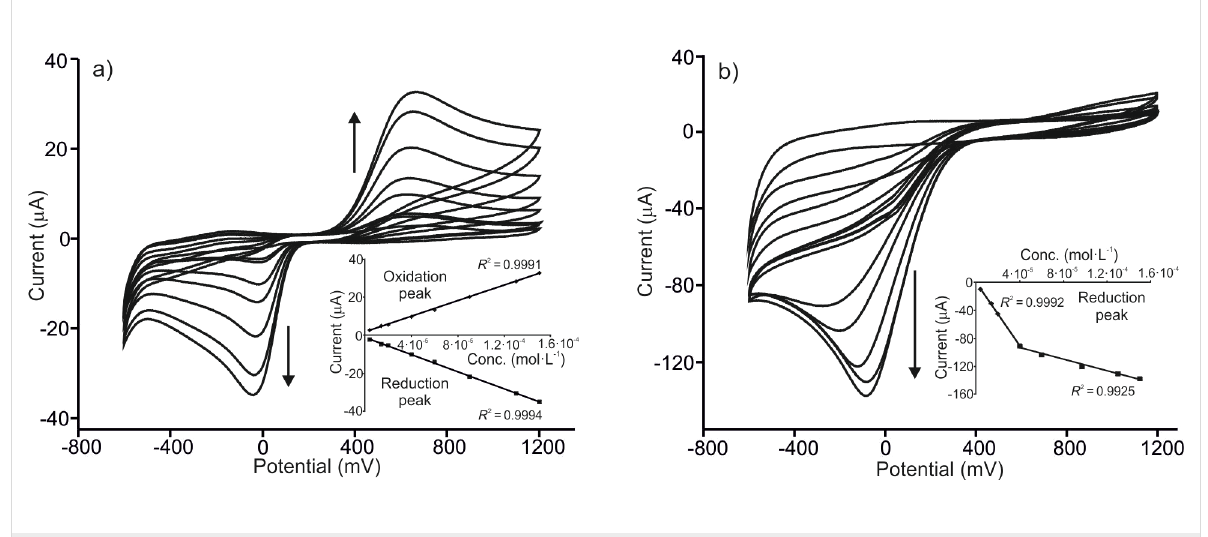
Figure 6: CVs of (a) PEDOT/PSS/LuPc 2 and (b) PEDOT/PSS/LuPc 2 -Tyr immersed in increasing concentrations of catechol (from 4.0 × 10 − 6 mol·L − 1 to 1.5 × 10 − 4 mol·L − 1 ). Scan rate 0.1 V·s − 1